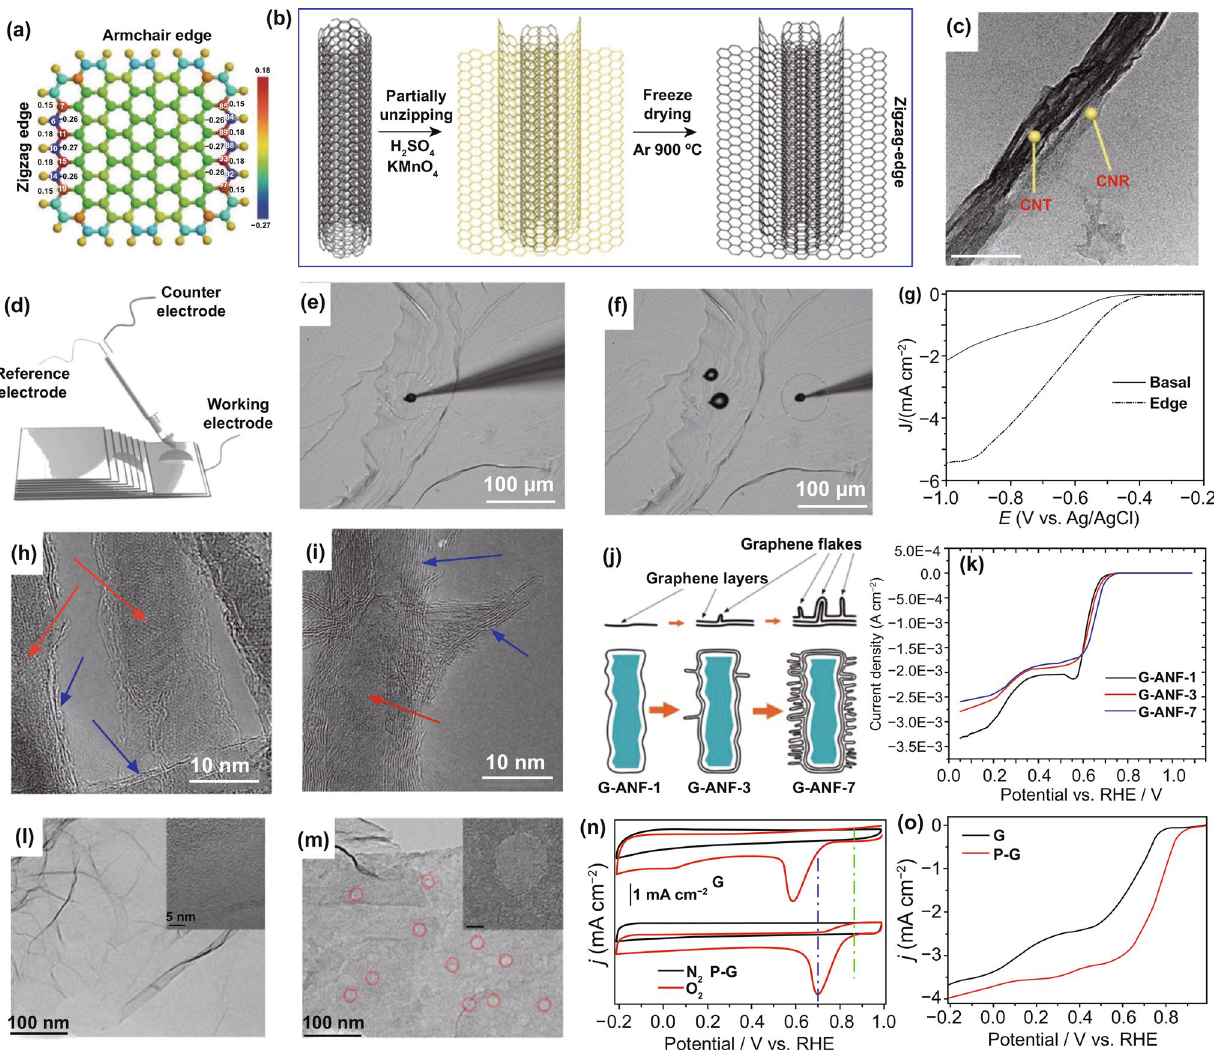
Fig. 3 Edge- and pore-defective nanocarbon catalysts for ORR. a Charge and spin density distributions of graphene model. Reproduced with permission from Ref. [39]. Copyright 2015, Royal Society of Chemistry; b schematic illustration of the synthesis of zigzag-type graphene nanoribbons on carbon nanotubes (GNR@CNT) catalyst; c TEM image of GNR@CNT. Reproduced with permission from Ref. [27]. Copyright 2018, Nature Publishing Group; d designed micro-apparatus for ORR electrochemical measurement; e , f optical images of the working electrode (HOPG) on the edge and basal plane; g LSV curves for specific locations on the HOPG. Reproduced with permission from Ref. [87]. Copyright 2014, Wiley–VCH; h , i TEM images of the graphene-coated alumina nanofibers (G-ANF) by different dwell time in the CVD chamber, 20 min for G-ANF-1, 60 min for G-ANF-3; j schematic illustration of the series of G-ANF material synthesis; k LSV curves for G-ANF samples in O 2 -saturated 0.1 M KOH solution. Reproduced with permission from Ref. [63]. Copyright 2016, Royal Society of Chemistry. TEM images of pristine graphene ( l , G) and Ar plasma-treated graphene ( m , P–G); n – o CV and LSV curves for G and P–G catalysts in 0.1 M KOH solution. Reproduced with permission from Ref. [29]. Copyright 2016, Royal Society of